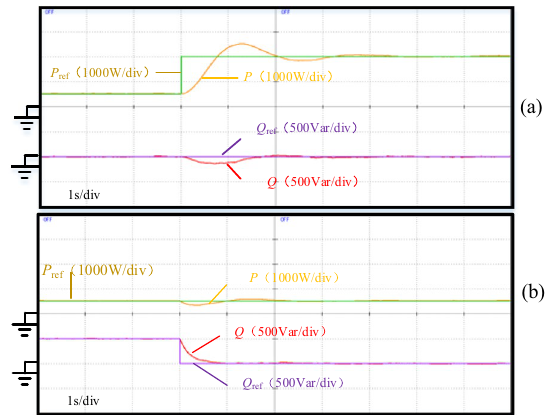
Fig. 8 Experimental waveforms of the power outer loop with compensation. (a) Active power P ref changes from 500 to 2000 W. (b) Reactive power Q